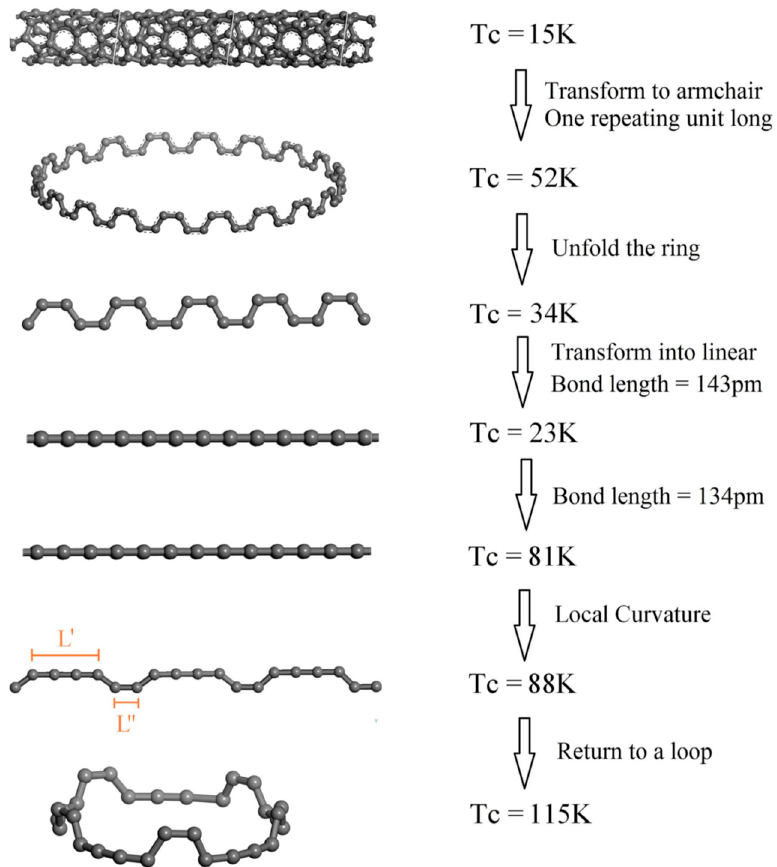
Figure 9. The journey of designing a 115 K superconductor. The different carbon structures are shown with increasing T C . Reproduced with permission from [37].